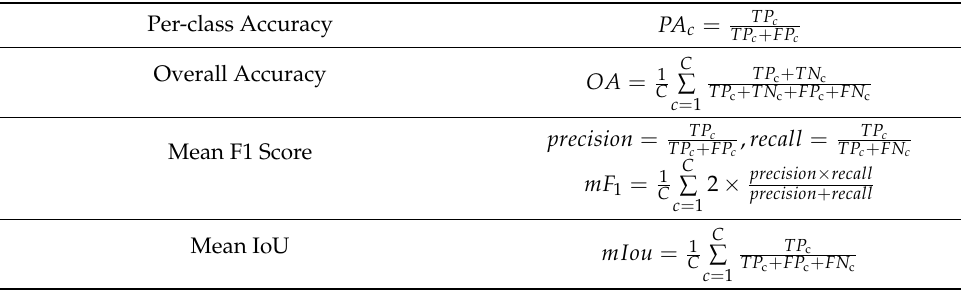
Table 2. Evaluation metrics for the experimental